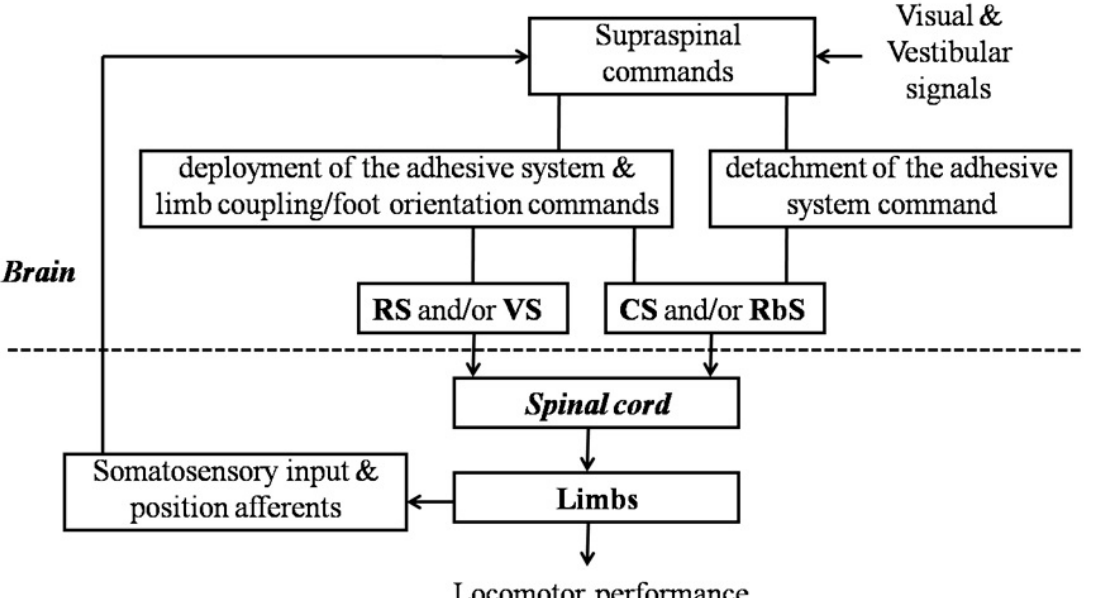
Figure 6. Main components of neural control mechanisms of adhesion locomotor pattern formation in pad-bearing species of lizards. Spinal cord generates the basic locomotor rhythm, and the effect is not being superimposed onto the effects of supraspinal commands, which are generated on the basis of sensory information and transmitted by the major descending tracts (reticulospinal (RS), vestibulospinal (VS), corticospinal (CS), and rubrospinal (RbS) tracts). Dorsal spinal pathways (CS and/or RbS) and ventral spinal pathways (RS and/or VS) participate, respectively, in the control of the deployment of the adhesive apparatus and the limb coupling/foot orientation. Mean- while, dorsal spinal pathways (CS and/or RbS) participate in the control of the detachment of the adhesive